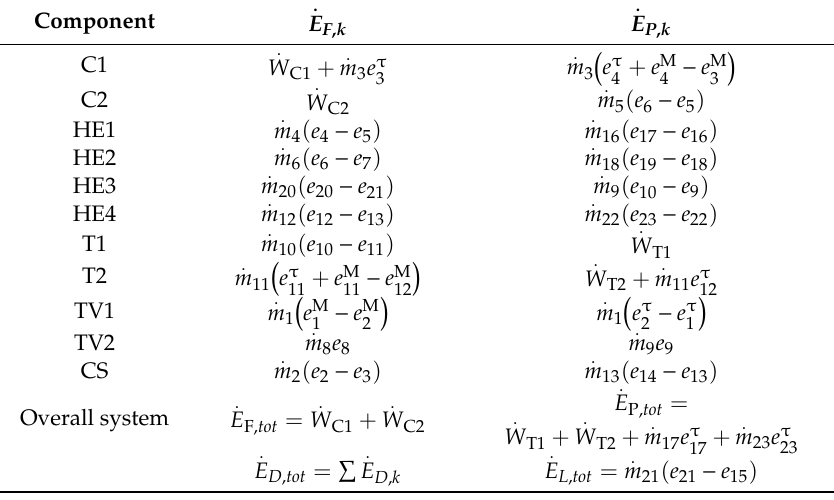
Table 1. The exergy definitions in the CCHP system based on TC-CCES.